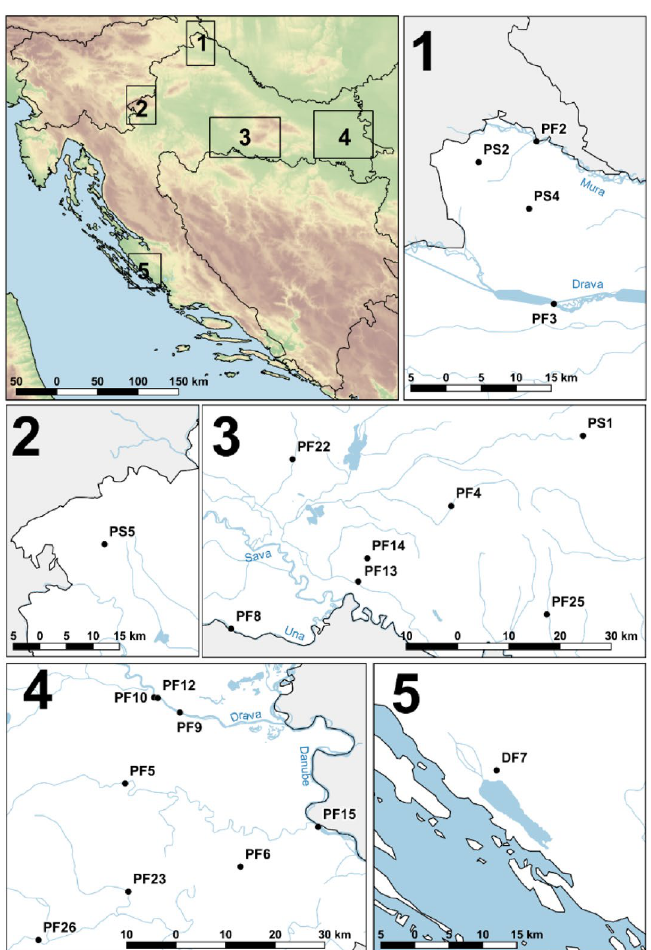
Figure 3. Positions of 21 water sampling locations in Croatia. P—Pannonian region, D—Dinaric region, F— lotic water system (flowing), S—lentic water system (stagnant). The map was generated using QGIS